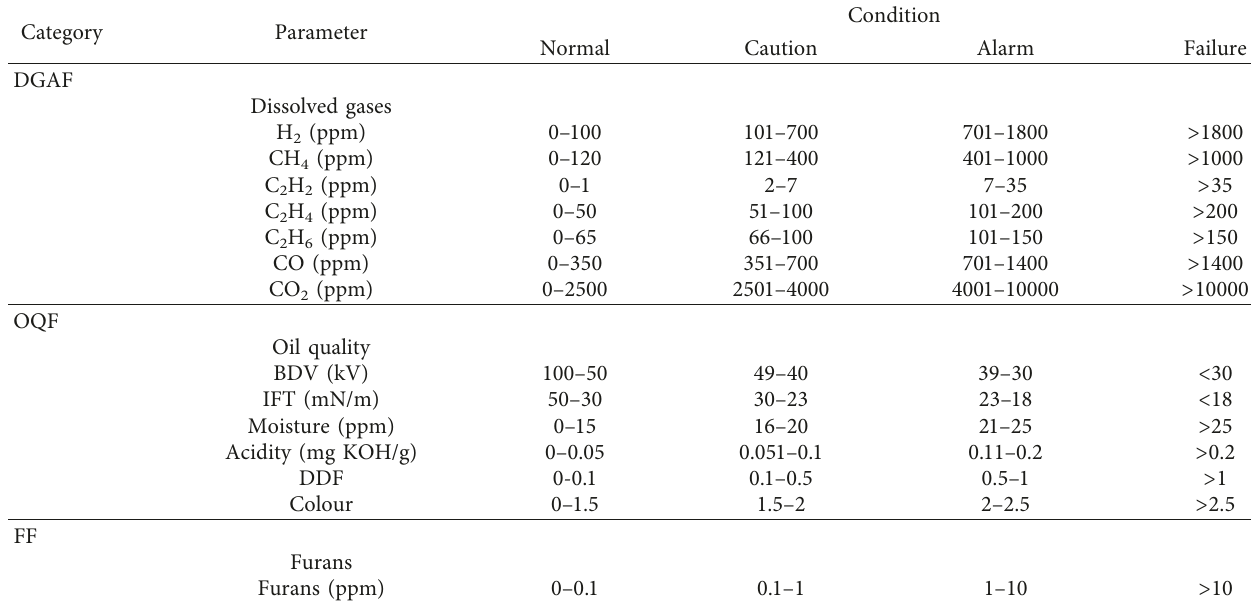
Table 2: Transformer standard parameter limits [1,